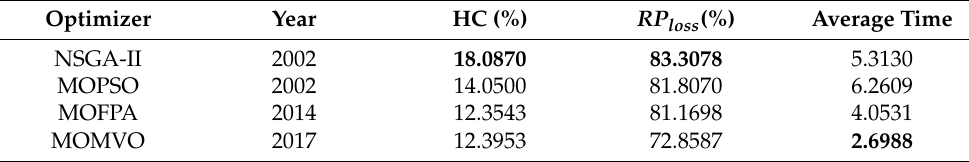
Table 14. The obtained HC and power loss reduction at different number of scenarios.